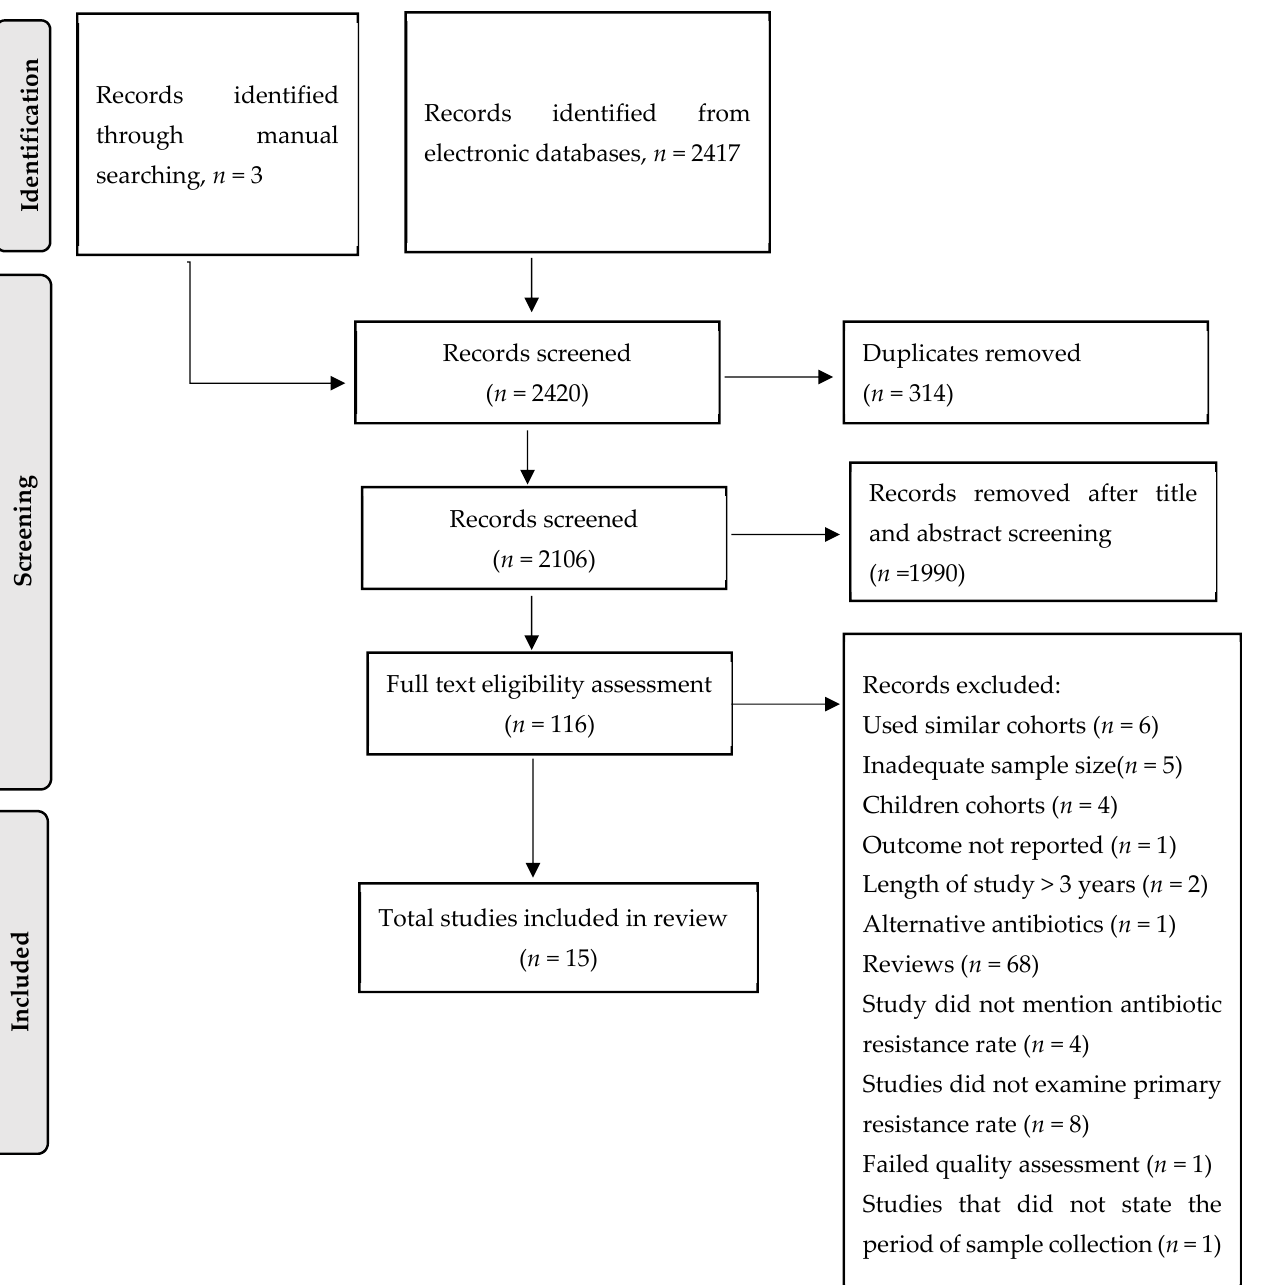
Figure 1. Flow chart of study selection. Exclusion criteria were: (1) Studies that measured the prevalence of alternative antibiotics for H. pylori treatment, (2) studies that reported prevalence results using < 50 isolates for culture method or <50 H. pylori positive gastric biopsies for nucleic acid-based method, (3) studies that only reported percentage of resistance rates with no description of the number of isolates used, (4) studies with no time frame of sample collection, (5) studies that clustered prevalence rates data more than three years, (6) studies that failed to state the percentage of primary antibiotic resistance in H. pylori isolates examined, and (7) studies that only examined the prevalence of resistance rate of secondary isolates.